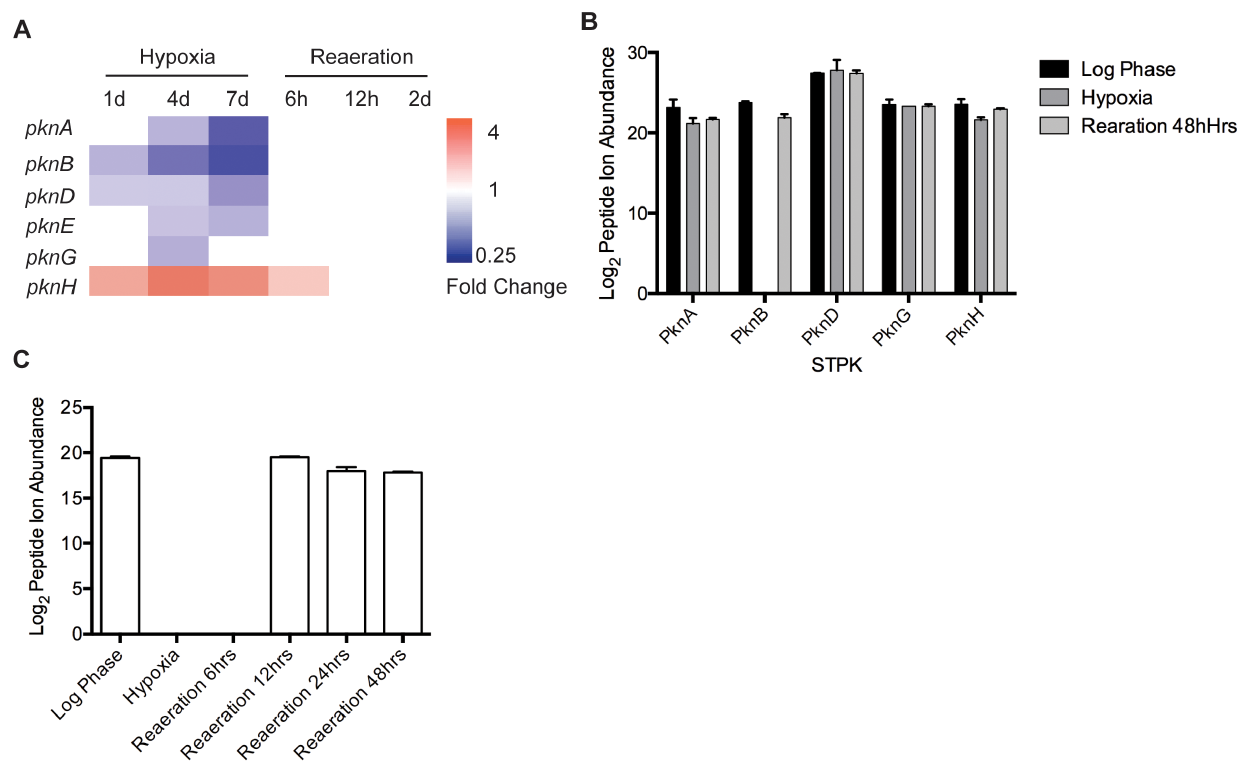
Figure 4. PknB transcript and protein levels change in response to oxygen. (A) Microarray analysis of STPK transcript levels during a hypoxia time course. (B) Quantitative MS analysis of STPKs in wild-type Mtb in log phase, day 7 of hypoxia, and day 2 of reaeration. (C) Quantitative MS analysis of PknB abundance in wild-type Mtb .